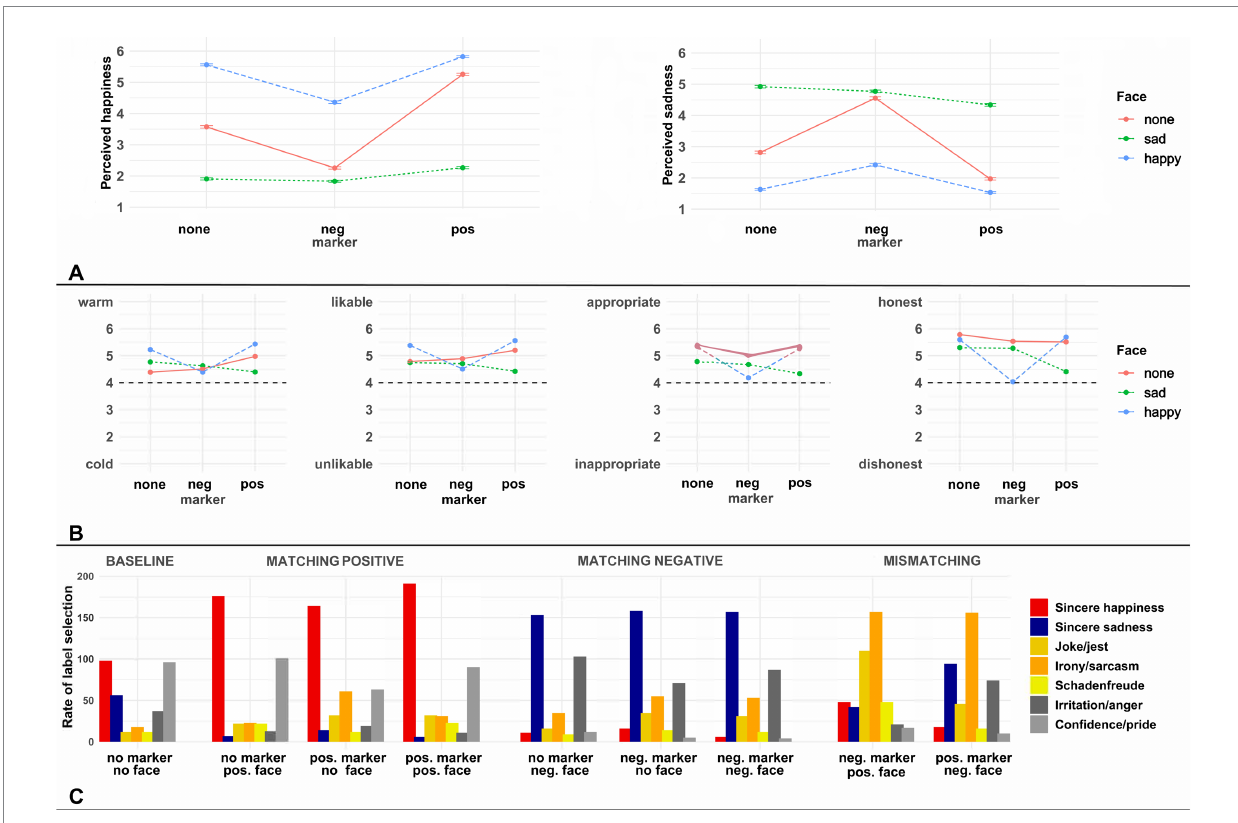
FIGURE 3 Results for all questions in Experiment 2. Panel (A) of this figure shows the mean scale ratings on the emotion perception questions, with error bars showing standard errors around the mean. Panel (B) displays mean ratings on the four semantic differentials addressing speaker perception, again with error bars showing standard errors around the mean. Panel (C) shows the rate (in total numbers) at which each of the seven potential utterance labels were selected for each condition in the question addressing communicative